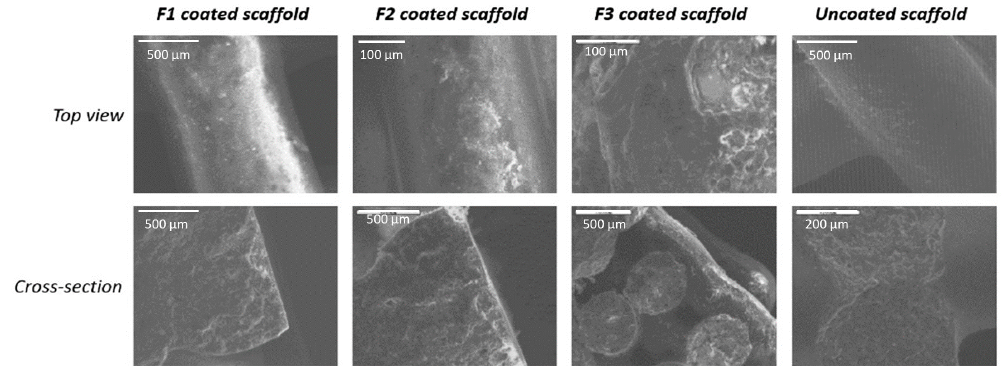
Figure 3. SEM images of coated and uncoated calcium phosphate cement (CPC) scaffolds.